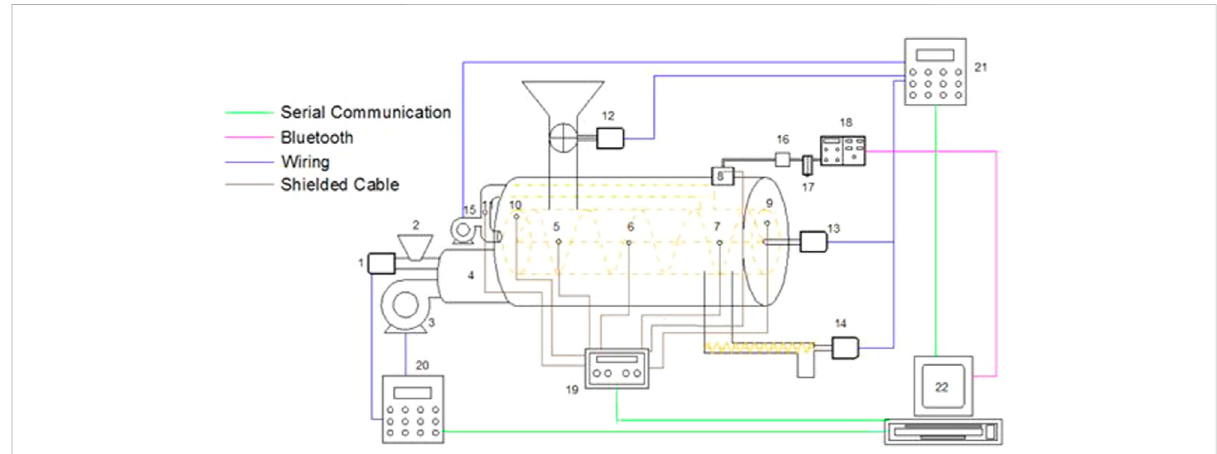
FIGURE 2 Pilot-scaleauger-typepyrolysisreactorusedtoproducebiocharfromagro-residuesgeneratedduringthepost-harvestingprocessesofquinoa and lupin. Legend: 1.HBP feeder,2. HBP hopper, 3.HBP blower,4. HBP frame, 5. Combustion chamber thermocouple (T1),6. Combustion chamber thermocouple (T2), 7. Combustion chamber thermocouple (T3), 8. Chimney thermocouple (T4), 9. Carbonization chamber outlet thermocouple (T5), 10. Carbonization chamber inlet thermocouple (T6), 11. Pyrolysis gas thermocouple (17), 12. Rotary vane valve, 13. Auger shaft and motor, 14. Discharge valve, 15 Pyrolysis gas burner, 16. Particle fi lter, 17. Condenser fi lter. 18. On line gas analyzer 19. Thermocouples data logger,